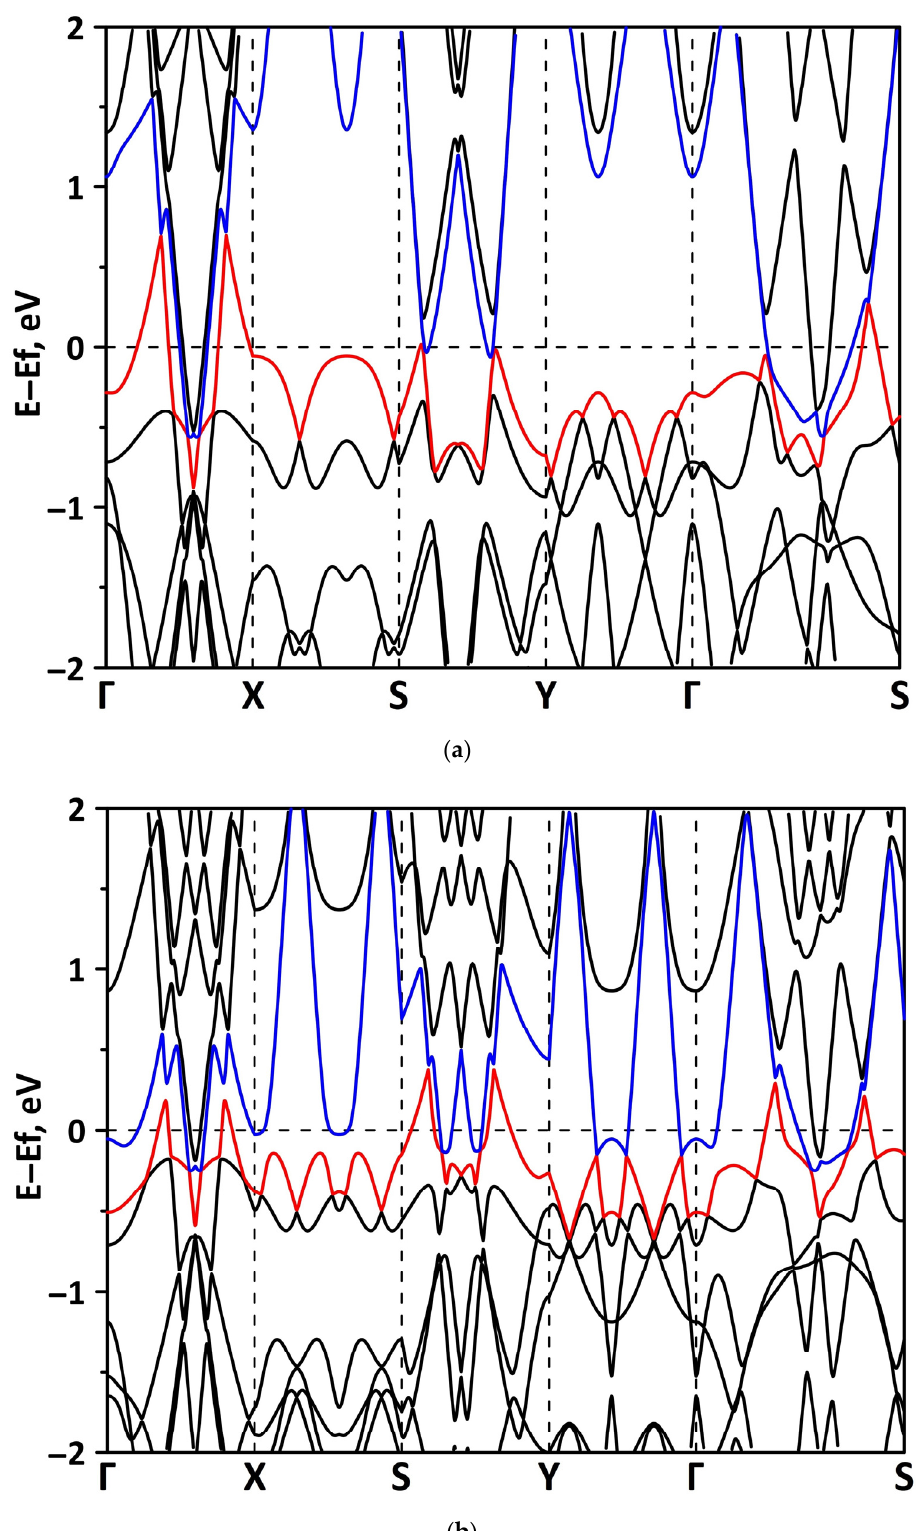
Figure 9. Fragments of the band diagrams near the Fermi level (shifted to 0 eV) of borophene/GaN heterostructure under uniaxial stretching by 1% ( a ) and 14% ( b ). The VBM is highlighted in red and the CBM is highlighted in blue.